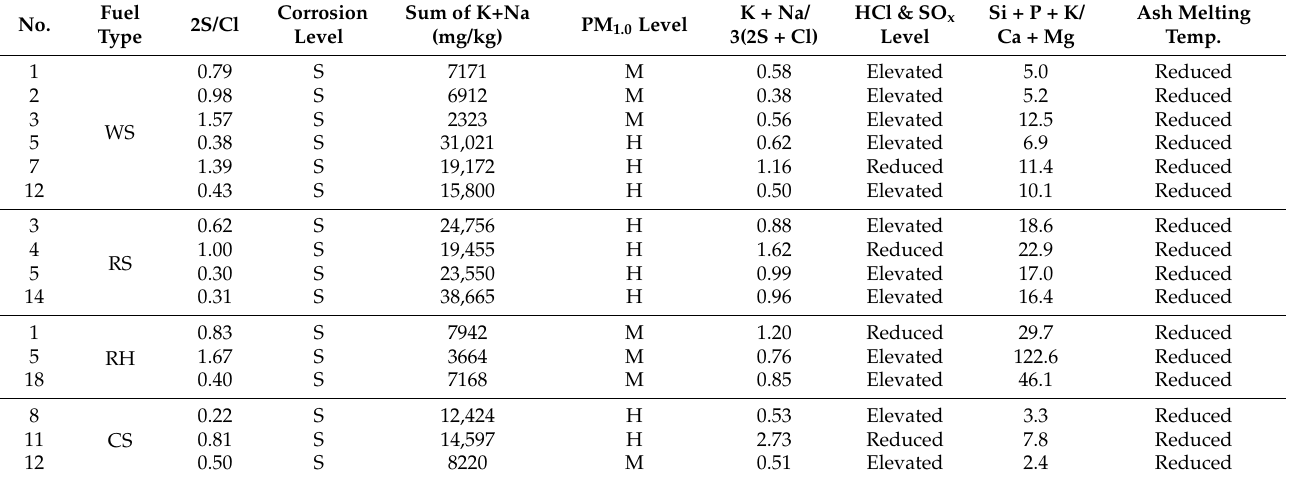
Table 8. Summary of fuel indices results and associated combustion